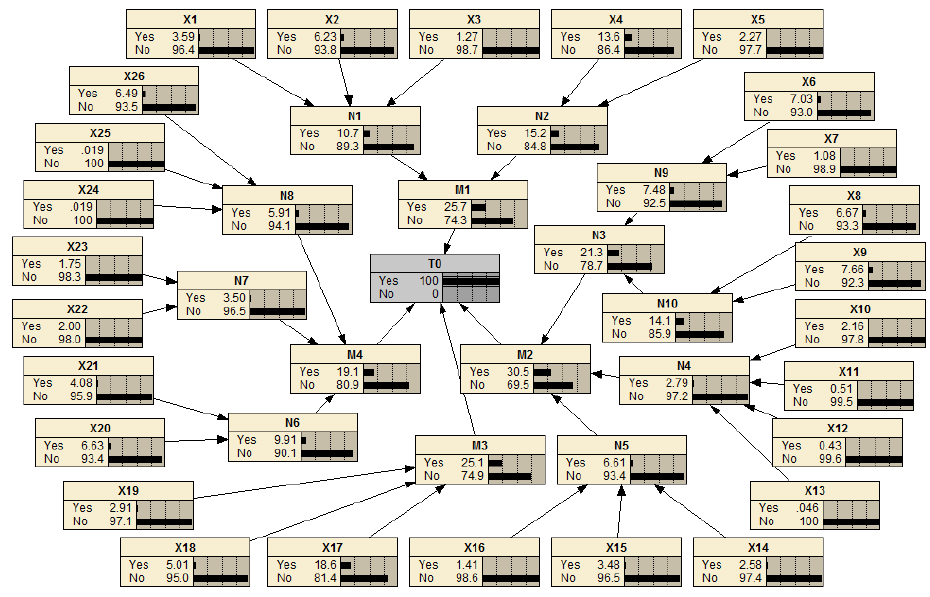
Figure 6. The posterior probability of each node. To find out the significant contributing factors leading to the CFIT accident, the pos- Table 6. The posterior probabilities of the root nodes. terior probabilities of the root nodes were sorted, and the results are shown in Table 6. The larger the probability value, the more significant the impact on the CFIT accident.